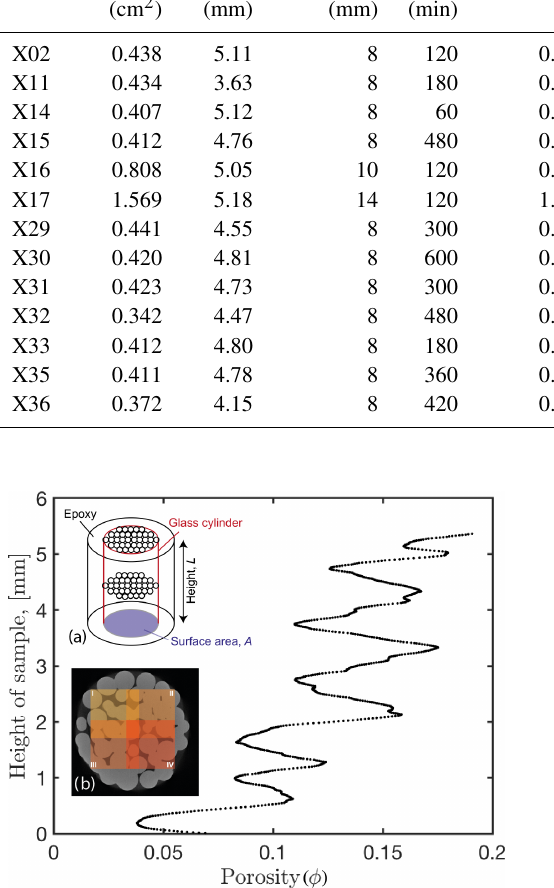
Figure 2. Computed porosity of each CT slice from the top to the bottom of a full sample ( z axis; sample Ex14). The diagram shows that gravity affects the porosity of the sample. Porosity minima cor- respond to distinct layers of glass bead within the sample. The in- set (a) provides a sketch of the sample structure. In the inset, red outlines the cylindrical shape, blue the surface area A of the cylin- der and L the height of the sample. (b) Chosen locations for the squared subsamples 1–4. Four additional subsamples (5–8) are sim- ilarly placed below subsamples 1–4 overlapping in the z